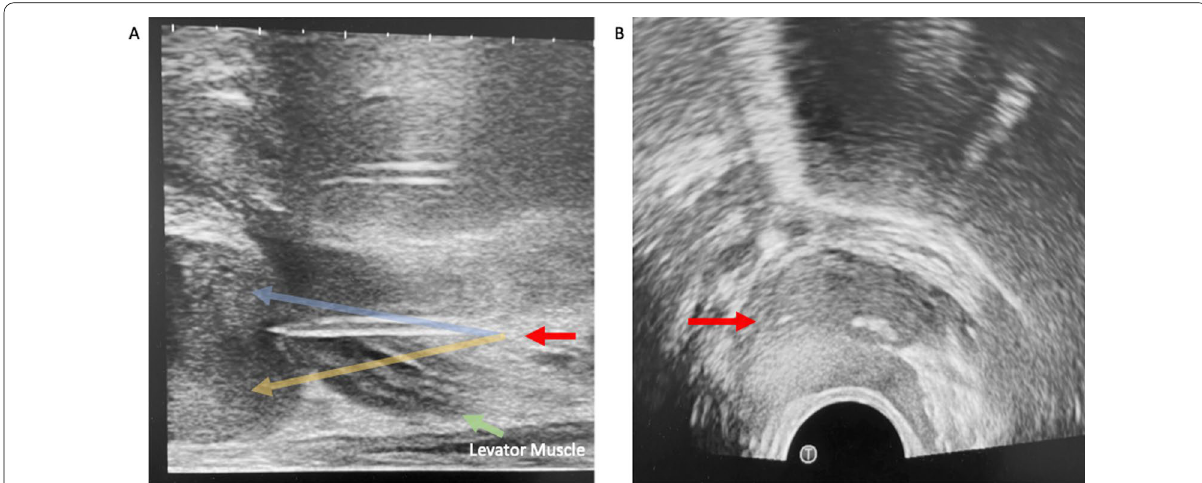
Fig. 12 In A , the red arrow shows the biopsy needle within the mid-portion of the gland. By angling the head of the probe superiorly (operators hand towards the floor), the anterior gland may be accessed (blue arrow). By angling the probe inferiorly (operators hand towards the ceiling), the posterior gland may be accessed (yellow arrow). B shows the tip of the biopsy needle in the axial plane, which is done to confirm needle position, prior to biopsy